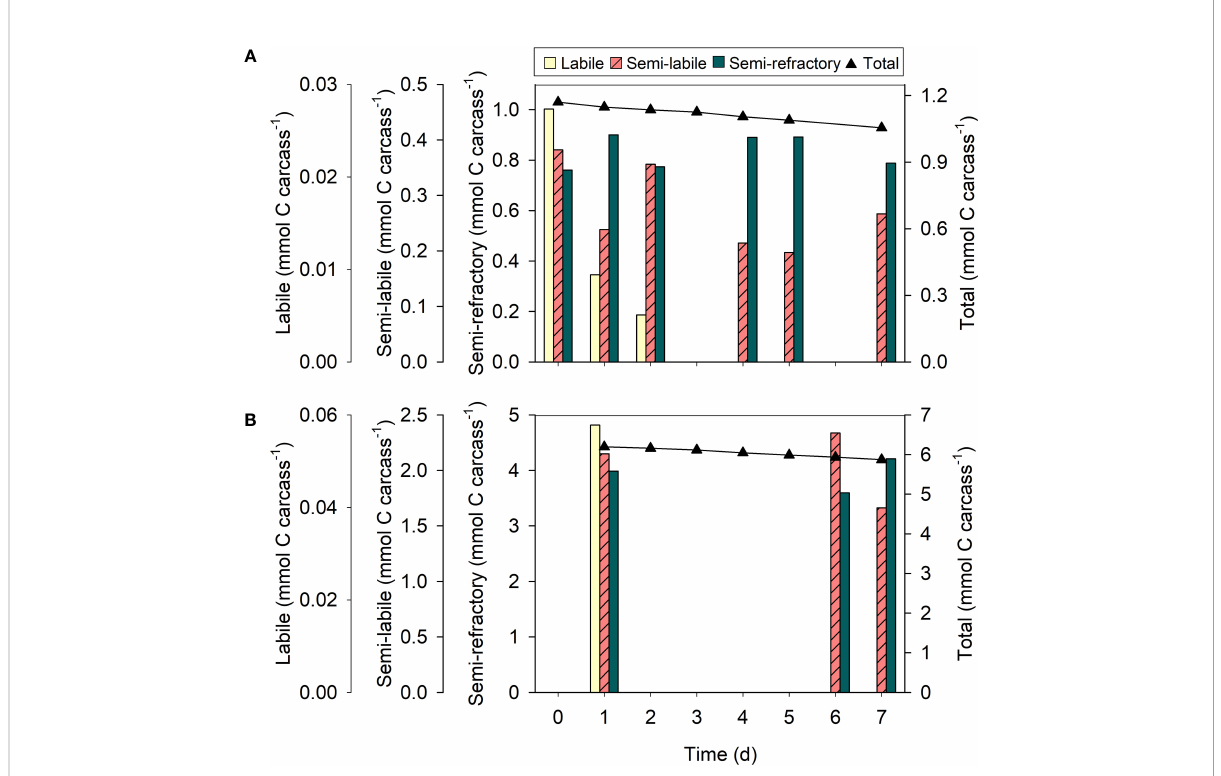
FIGURE 6 Organic carbon fractions of krill carcasses at different stages of degradation. Changes over time in organic carbon fractions associated with carcasses of (A) Thysanoessa raschii and (B) Meganyctiphanes norvegica . Black symbols represent the total amount of carbon in the carcasses per day. Only one carcass was measured per